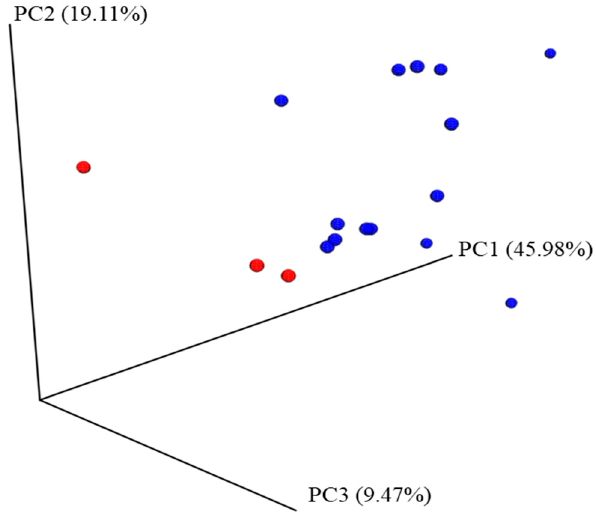
Figure 1. Principal coordinates analysis (PCoA) plot. For its construction, the weighted Unifrac method was used to compare the bacterial communities among samples from non-tolerant ( n = 3) and tolerant ( n = 14) infants with non-IgE mediated cow’s milk protein allergy (NIM-CMPA), based on their phylogenetic relationship. Percentages shown in the axes represent the explained variance. Blue circles illustrate samples from tolerant infants whereas red circles illustrate those that maintain active hypersensitivity after the standardized oral challenge (SOC). Analysis of molecular variance (AMOVA) was used to assess the statistical significance of the spatial separation between both groups ( p = 0.02).